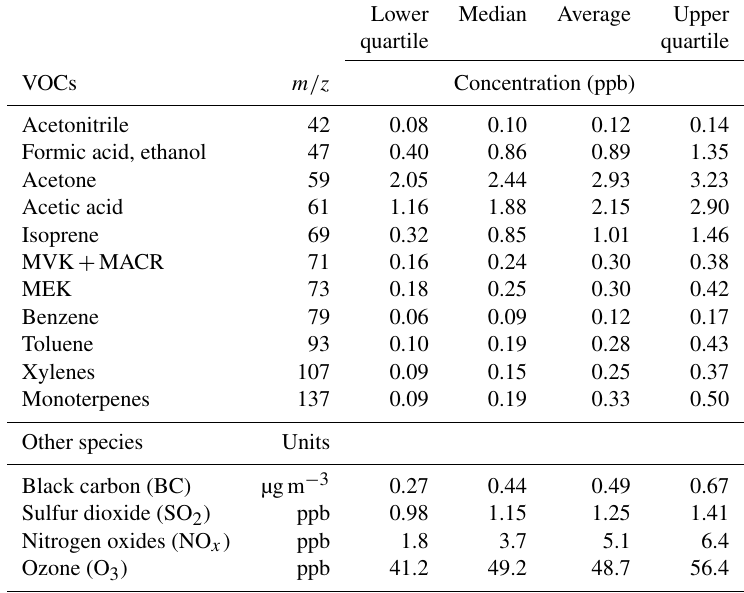
Table 1. Concentrations (5min averages) of VOCs and other pollutants during the Patras summer campaign.